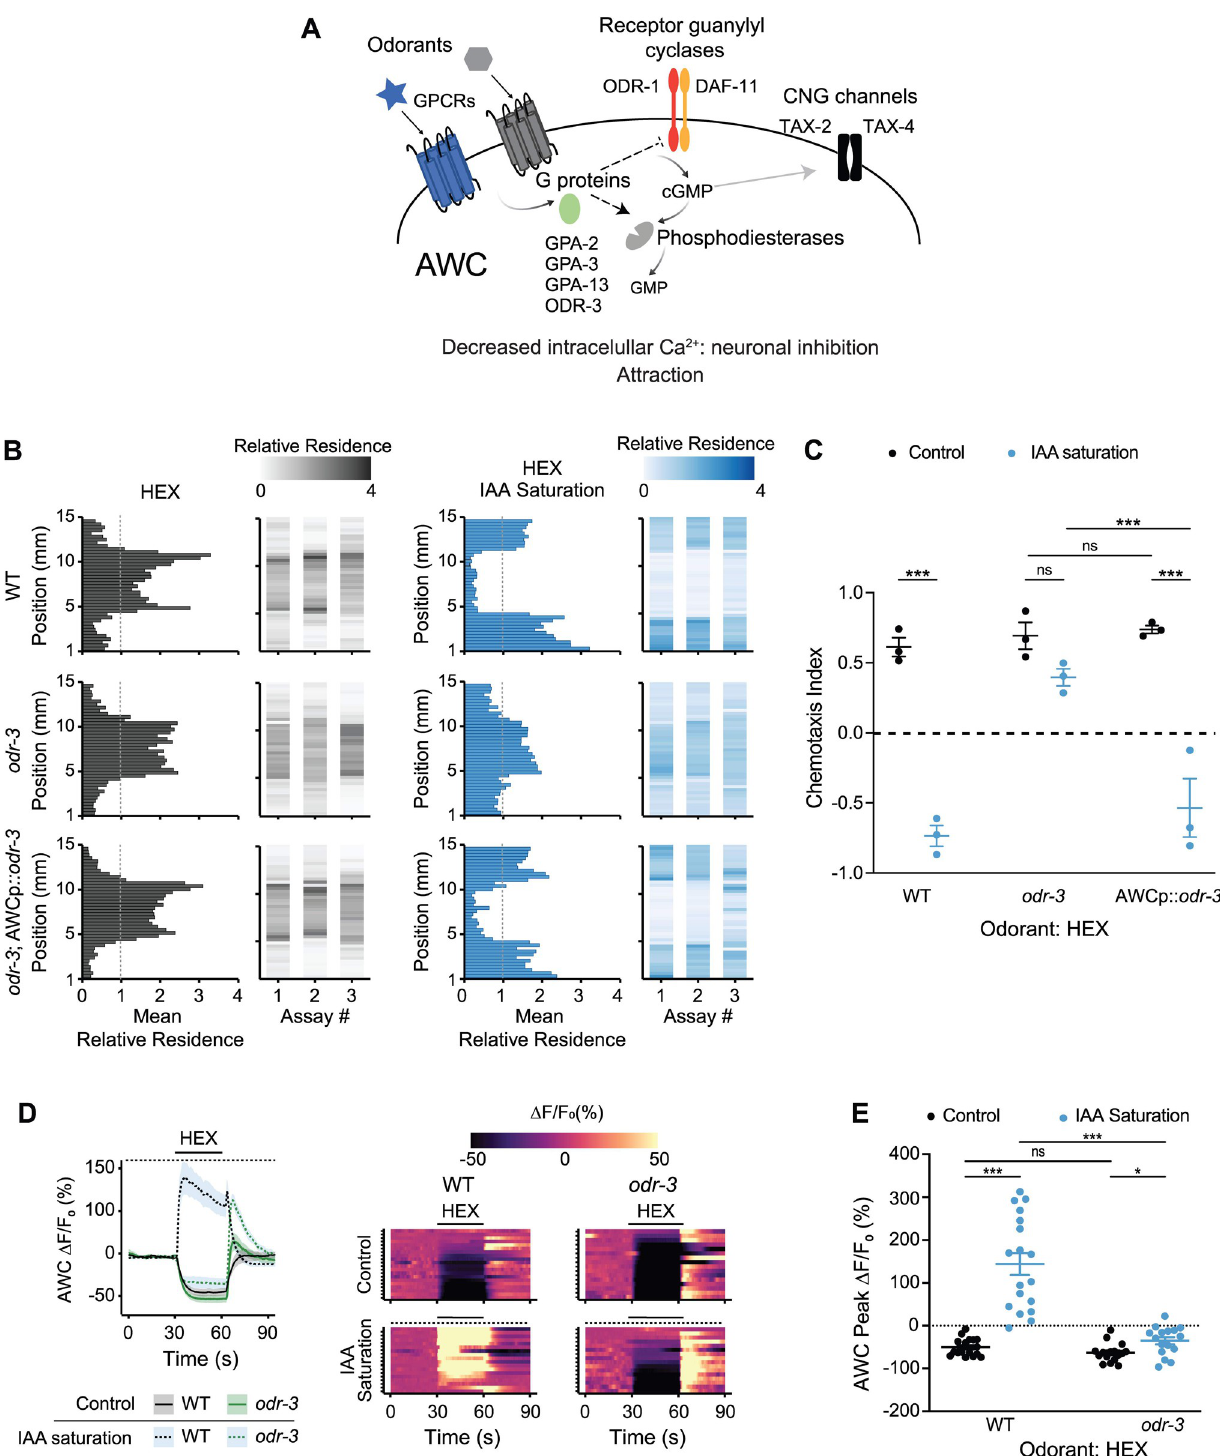
Fig 3. The ODR-3 G α protein is required for hexanol-mediated activation of AWC in sIAA. (A) Cartoon of the olfactory signal transduction pathway in AWC. Adapted from [61]. (B) Average residence histograms and heatmaps as described for Fig 1D. n = 20–30 animals per assay; 3 biological replicates. An odr-3 cDNA was expressed in AWC under the odr-1 promoter. The concentration of hexanol was 10 − 4 . (C) Chemotaxis indices calculated from behavioral assays shown in B. Each dot is the chemotaxis index from a single assay in behavior chips. (D) (Left) Average changes in GCaMP3 fluorescence in AWC in response to a pulse of 10 − 4 hexanol in wild-type and odr-3(n2150) mutants. The presence of saturating chemicals in the imaging chip at 10 − 4